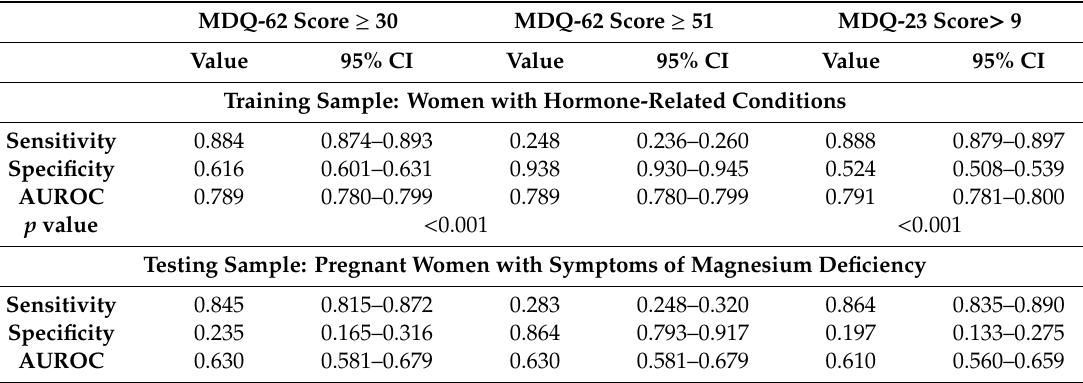
Table 1. Diagnostic performance of MDQ-23 compared with that of MDQ-62 using a serum magnesium level cut-o ff of 0.8 mmol / L.